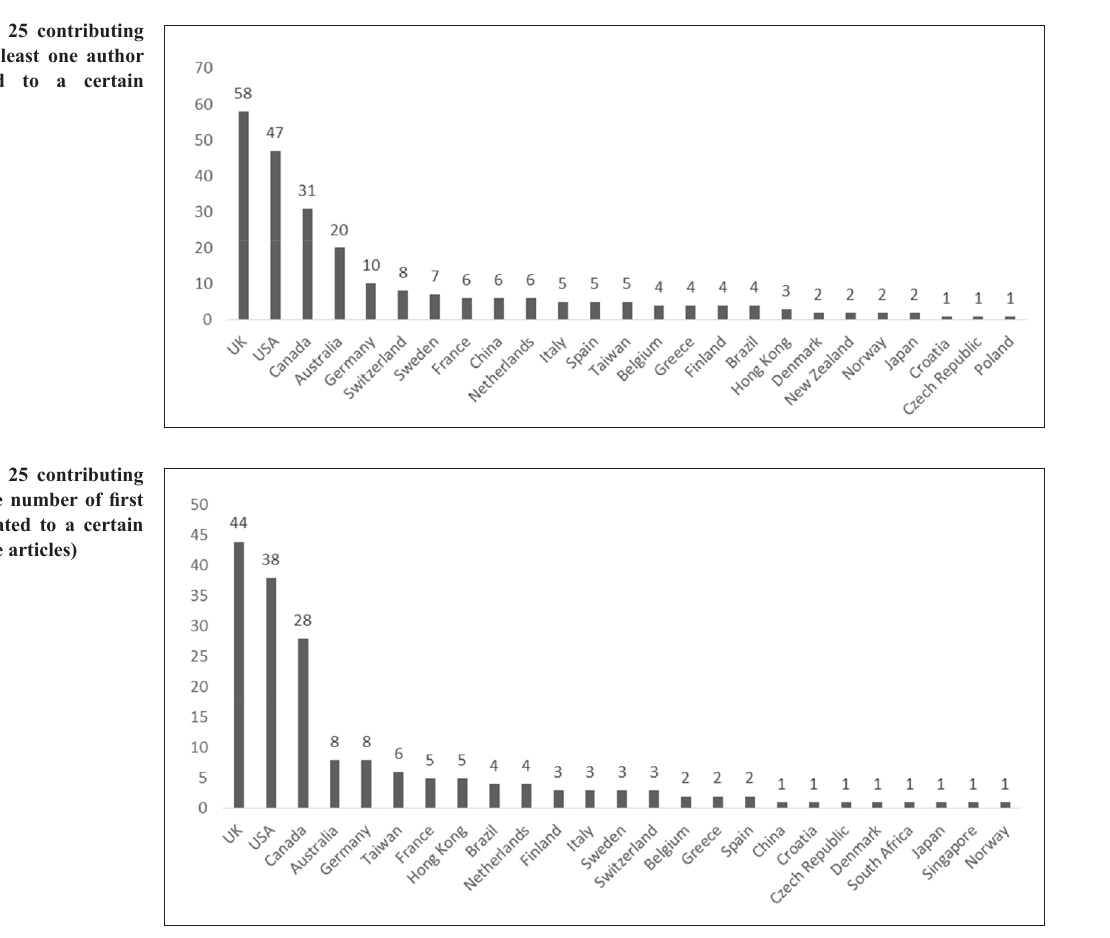
Figure 1. Top 25 contributing countries (at least one author was affiliated to a certain country)